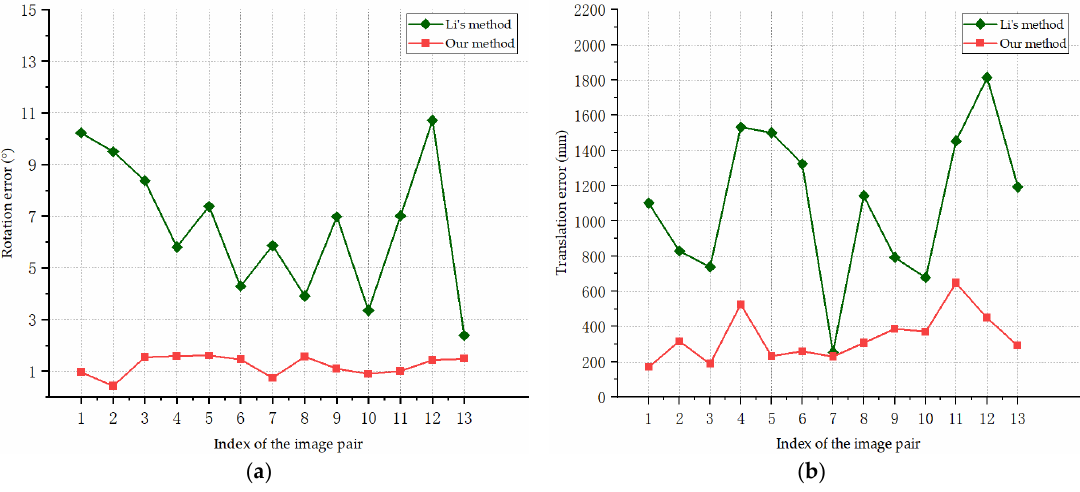
Figure 14. Pose estimation errors for the simulated images of Model 2: ( a ) Rotation errors; ( b ) Translation errors.